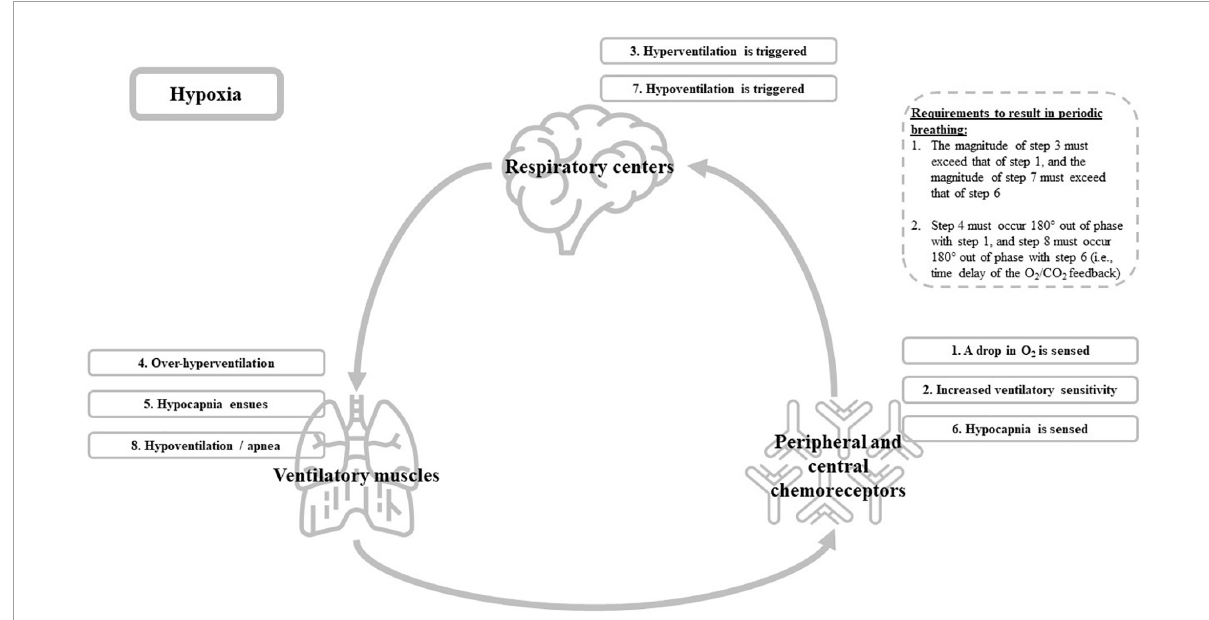
FIGURE1 Graphical overview of the ventilatory control system and the hypoxia-associated cascade (i.e., step 1–8) that eventually could trigger periodic breathing during